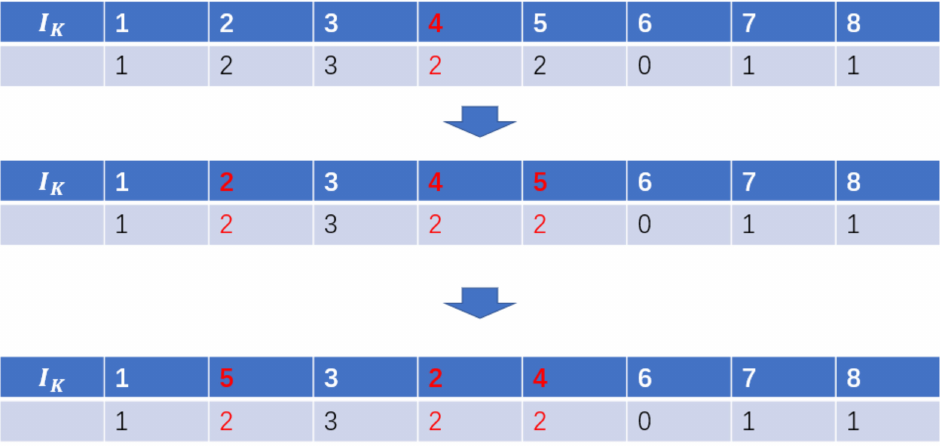
Figure 2. The walking